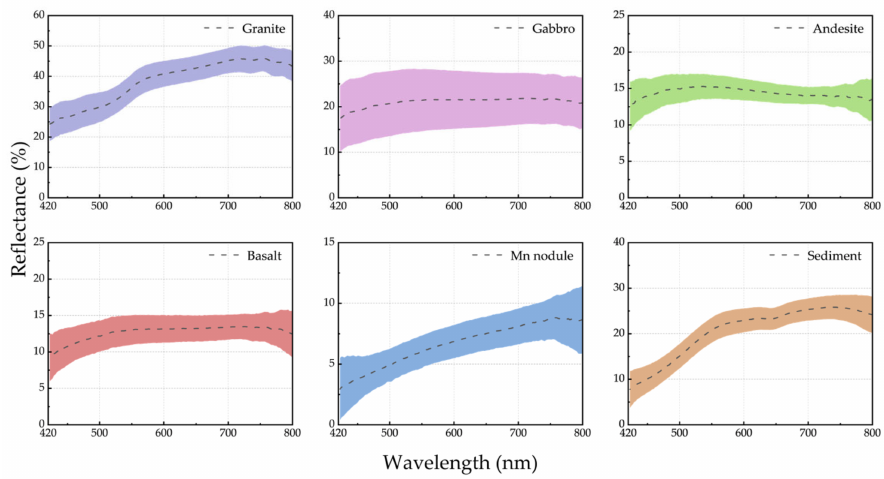
Figure 12. The corrected reflectance spectrum of granite, gabbro, andesite, basalt, manganese nodules, and sediment in 420 nm to 800 nm. The dashed lines are the mean spectrum, and the color-filled areas represent the range of the mean ± one standard deviation.